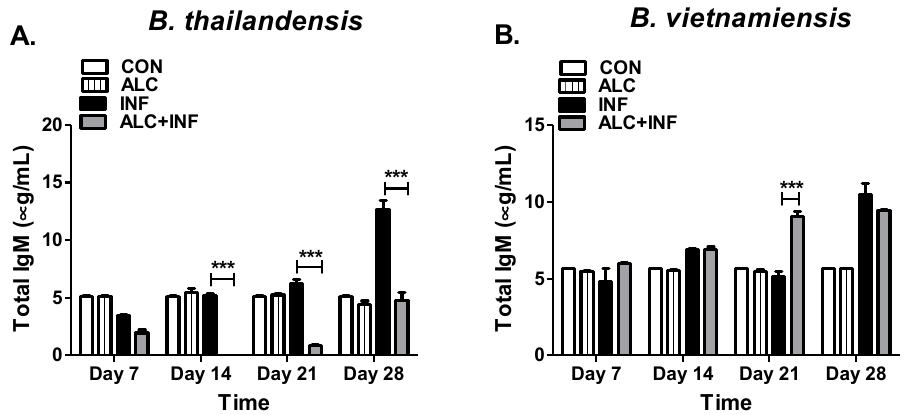
Figure 3. Total IgM concentration in mice infected with B. thailandensis or B. vietnamiensis . Mice were administered alcohol (4.4 g/kg) or PBS (i.p). At 30 min post binge alcohol, mice were intranasally infected with ( A ) B. thailandensis or ( B ) B. vietnamiensis (1 × 10 5 ). Whole blood was collected weekly until 28 days PI. Total IgM in mice were determined by ELISA with an optimal 1:20,000 dilution. Horizontal line with asterisk (*) represents statistical comparison between INF and ALC+INF groups among weekly blood collections determined by one-way ANOVA, n = 3. *** p ≤ 0.001.